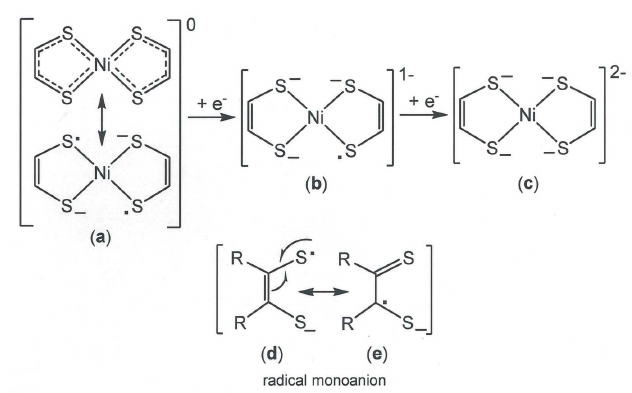
Figure 1 ( a )–( c ) Dithiolene-based electron-transfer reactions within nickel(II) bis(dithiolene) complexes whereby the ligands are transformed from radical monoanions to fully reduced ene-1,2-dithiolate dianions. ( d )–( e ) Resonance forms within the dithiolene radical